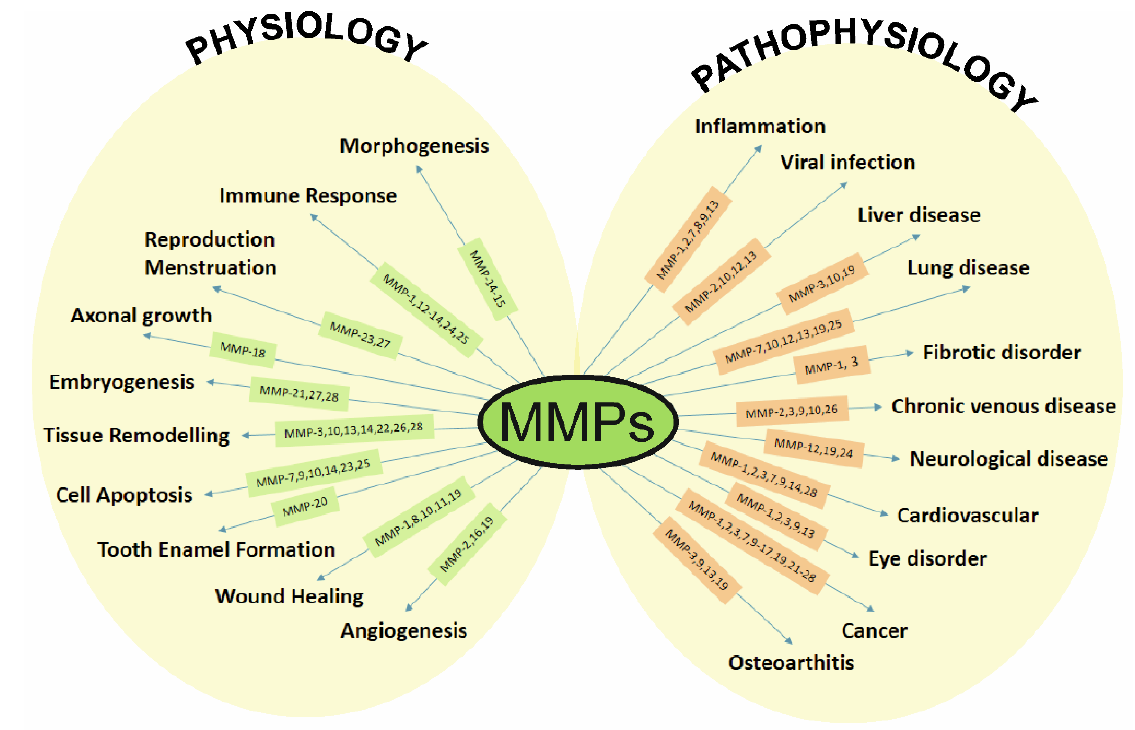
Figure 1. Physiological and pathophysiological processes regulated by MMPs.